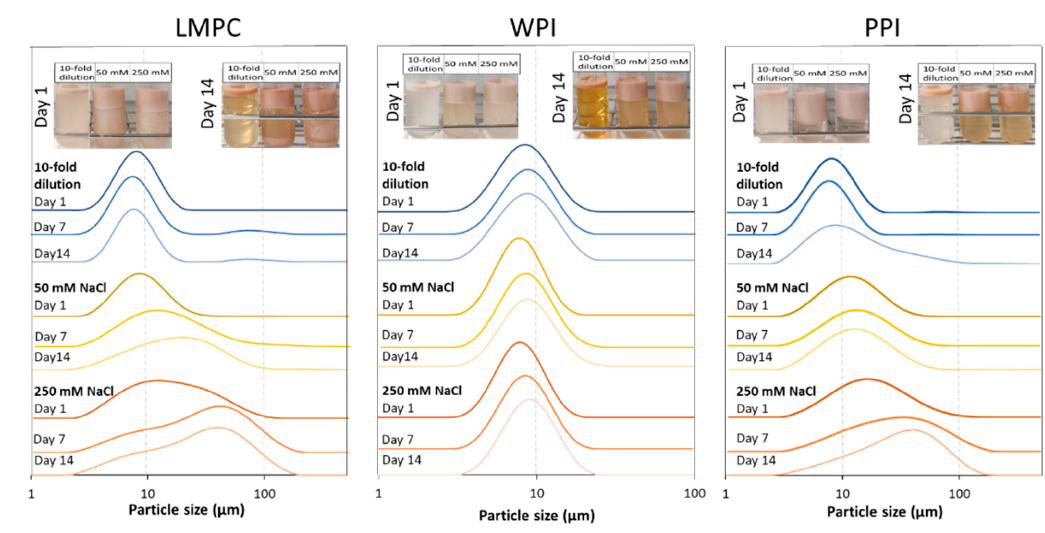
Figure 11. Droplet size distribution of W 1 /O/W 2 emulsions stabilized with LMPC, WPI and PPI after addition of 50 mM NaCl ( Δ ( П W2 – П W1 ) = 0.46 MPa), 250 mM NaCl ( Δ ( П W2 – П W1 ) = 2.56 MPa) and 10-fold water dilution ( Δ ( П W2 – П W1 ) = − 0.54 MPa) of W 2 over a storage period of 14 days; inset images show the visual appearance of the emulsions after 1 and 14 days of storage.